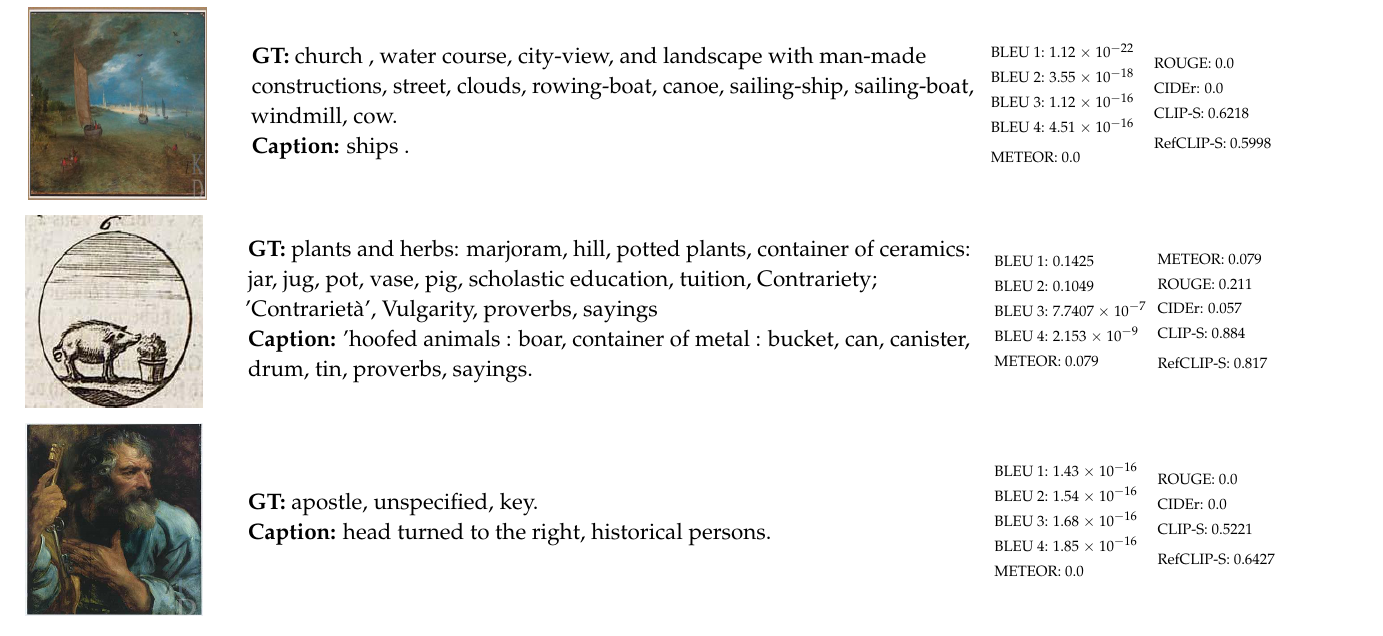
Figure 3. Examples of images from the Iconclass Caption test set, their corresponding ground-truth and generated captions and the values of evaluation metrics for those